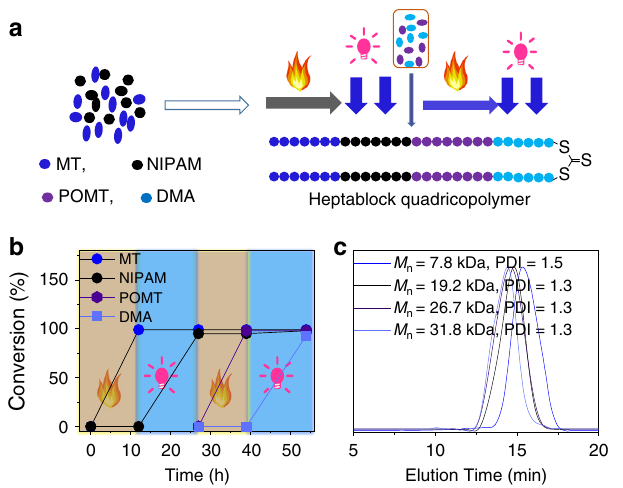
Fig. 5 Synthesis of heptablock quadicopolymer. a Outline of formation of heptablock quadicopolymer. b Monomer conversions vs. polymerization time for synthesis of heptablock quadricopolymer. c SEC curves for resulting polymers at different polymerization time